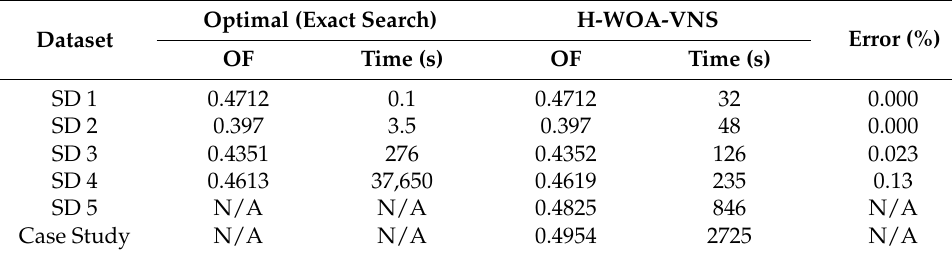
Table 15. Comparison of the average results of H-WOA-VNS over 10 runs against exact